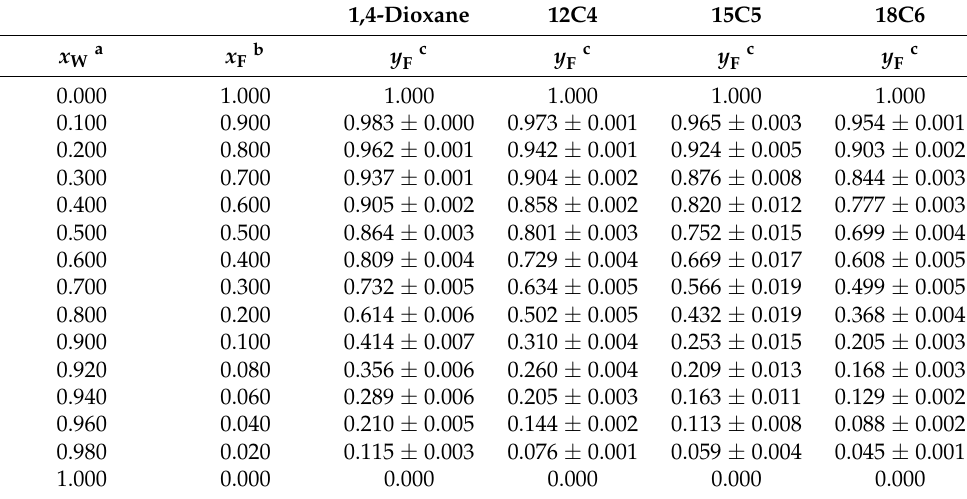
Table 3. The mole fraction of formamide ( y F ) in the solvation sphere of 1,4-dioxane, 12C4, 15C5 and 18C6, in the process of preferential solvation in dependency of the mole fraction of water ( x W ) or formamide ( x F ) in the mixture F +